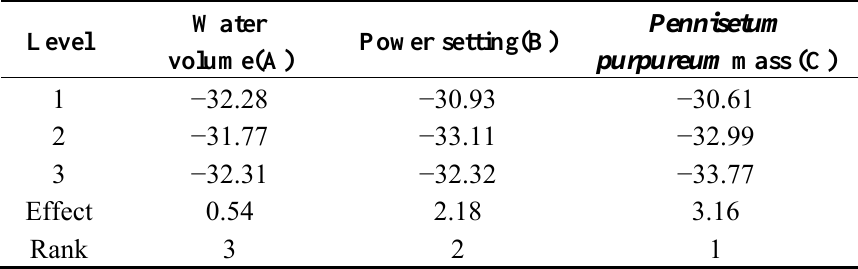
Table 3. Integration results of response in Taguchi